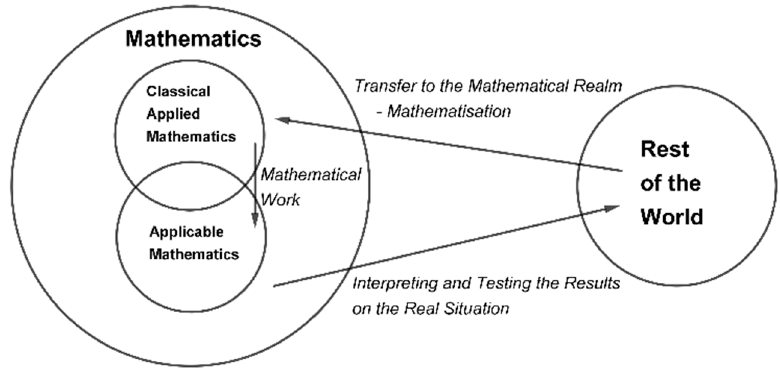
Figure 1. Pollak’s modeling cycle (source: adopted from [5]).